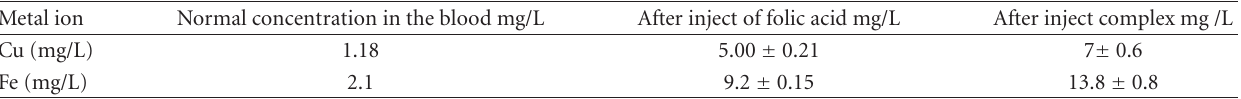
Table 5: Comparison between the normal, folic acid case and folic acid metal complex case percentage of Cu and Fe elements in the serum of